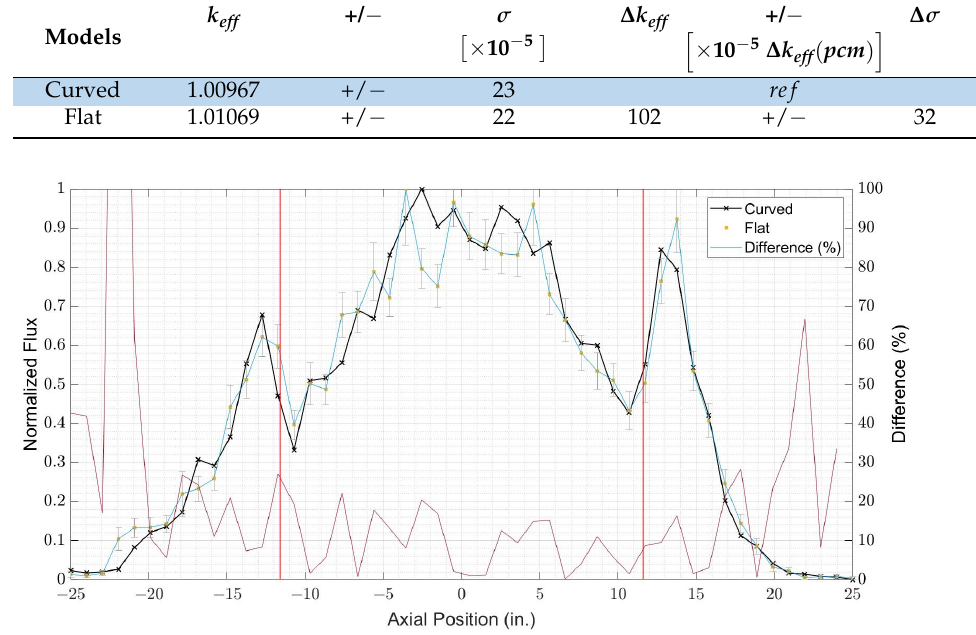
Figure 11. The axial flux for curved and flat core; difference (%) line indicates the error percentage between curved and flat values, while the vertical red line indicates the active fuel